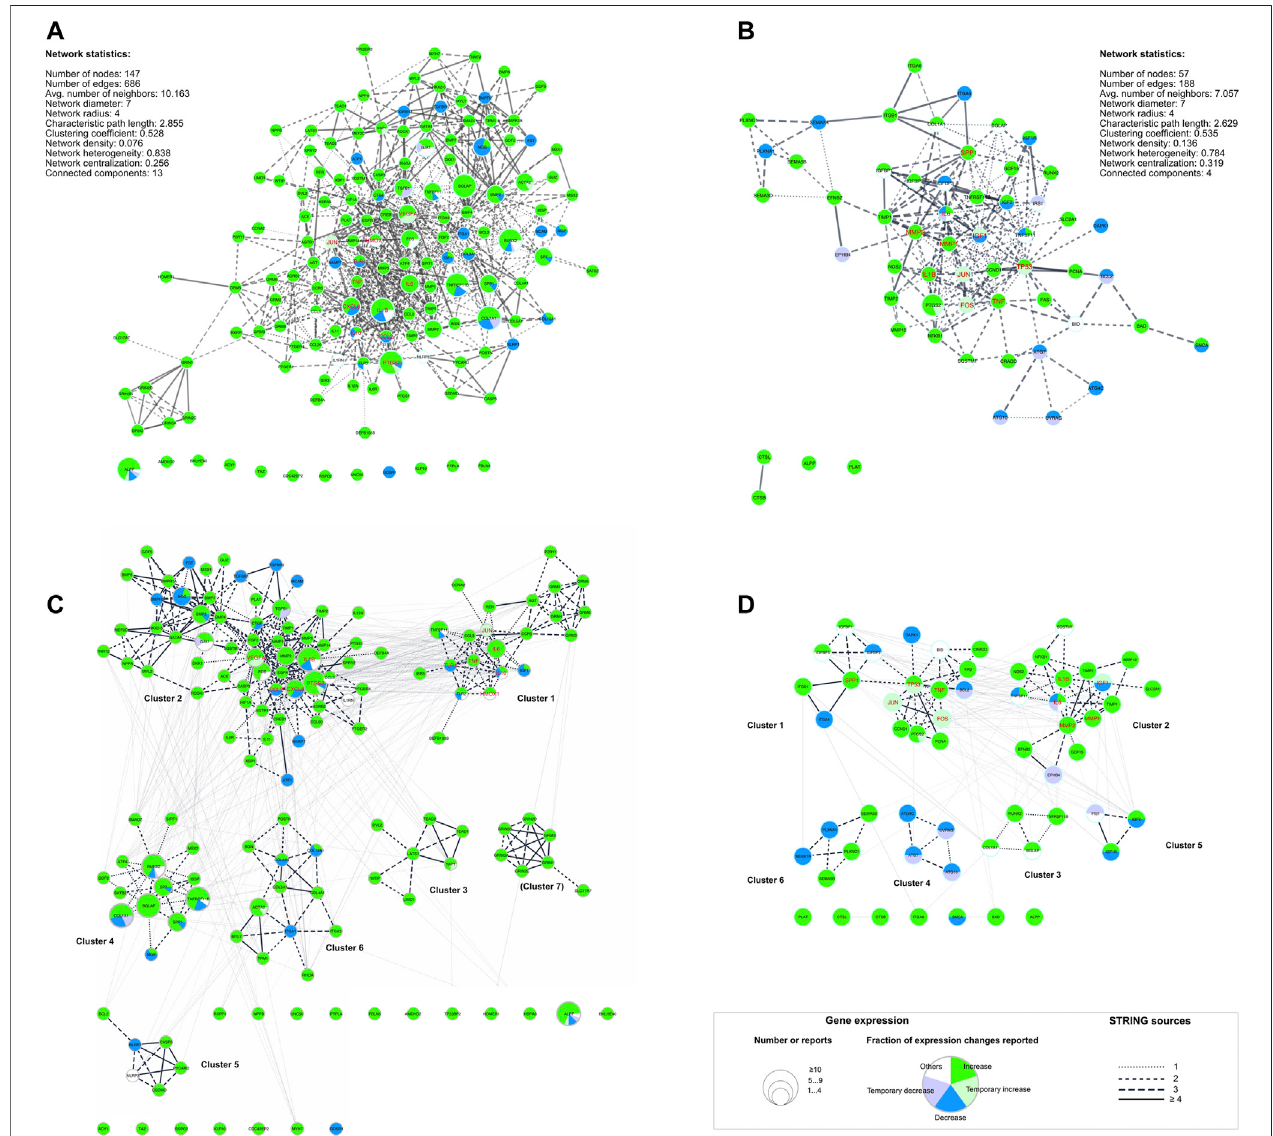
FIGURE 5 | Dynamic (A, C) and static (B, C) protein-protein-interaction (PPI) networks generated using differential expressed genes (DEG) lists ( Table 4 ). (A, B) PPI networks including basic network statistics for each were generated using STRING-DB. (C, D) show the same networks as in (A, B) but herein, the identi fi ed subnetworks are emphasized and labeled ( Table 4 , Supplementary Table S8 ). The legend applies to all four networks: The node size corresponds to the number of reportsidenti fi edfor therespectiveunderlying gene. The edges ’ linestyledepicts the number ofSTRING sources forthe given connection.Additionally,hub genes identi fi ed with cytoHubba (Chin et al., 2014) were colored red ( Table 5 ). For the complete networks (A, B) and each of the subnetworks (C, D) pathway analysis was applied ( Supplementary Table S8 ).